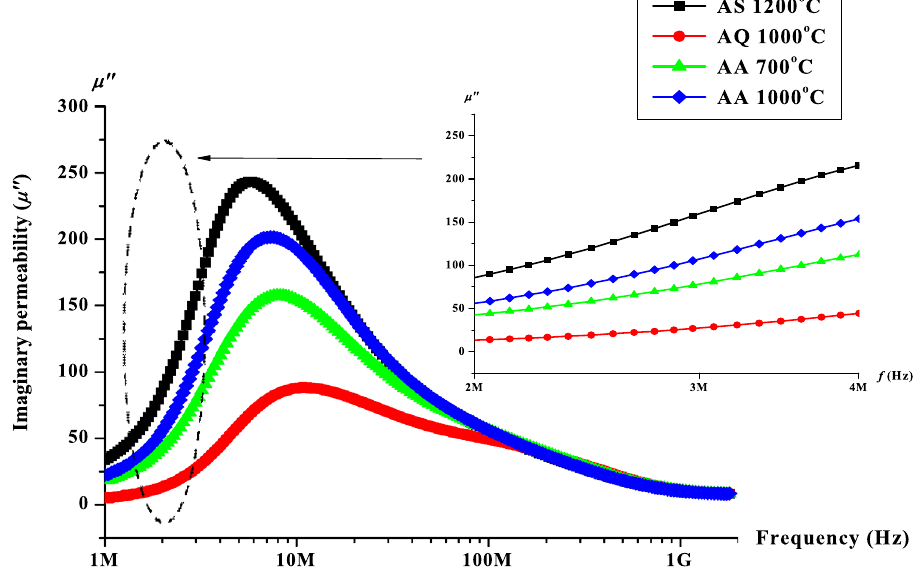
Figure 6. Graph of imaginary permeability, µ ″ versus frequency after sintering at 1200 °C, after quenching at 1000 °C, after annealing at 700 and 1000